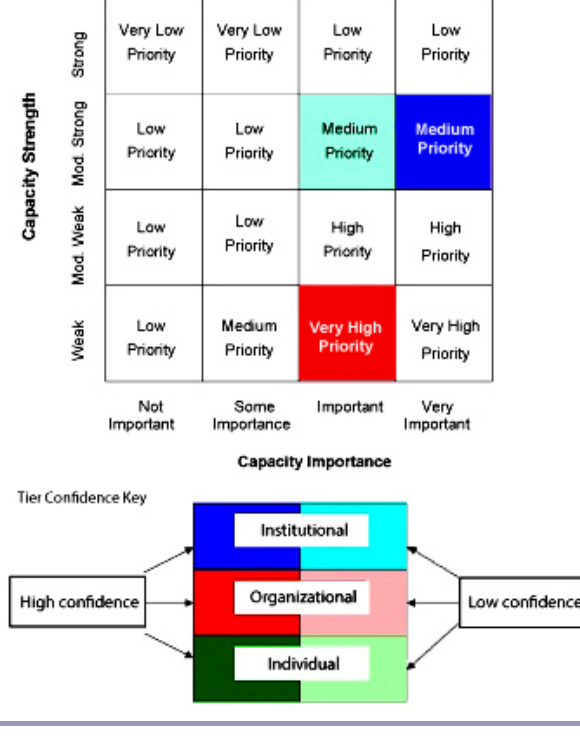
Fig. 3. Institutional tier’s governance capacity as perceived by the three community tiers (mock